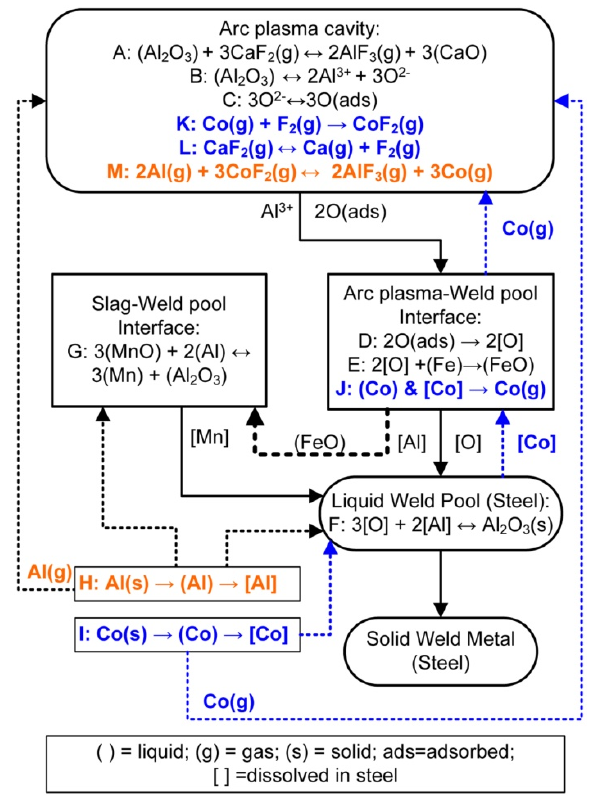
Figure 7. SAW reaction flow diagram with Al and Co powder additions.